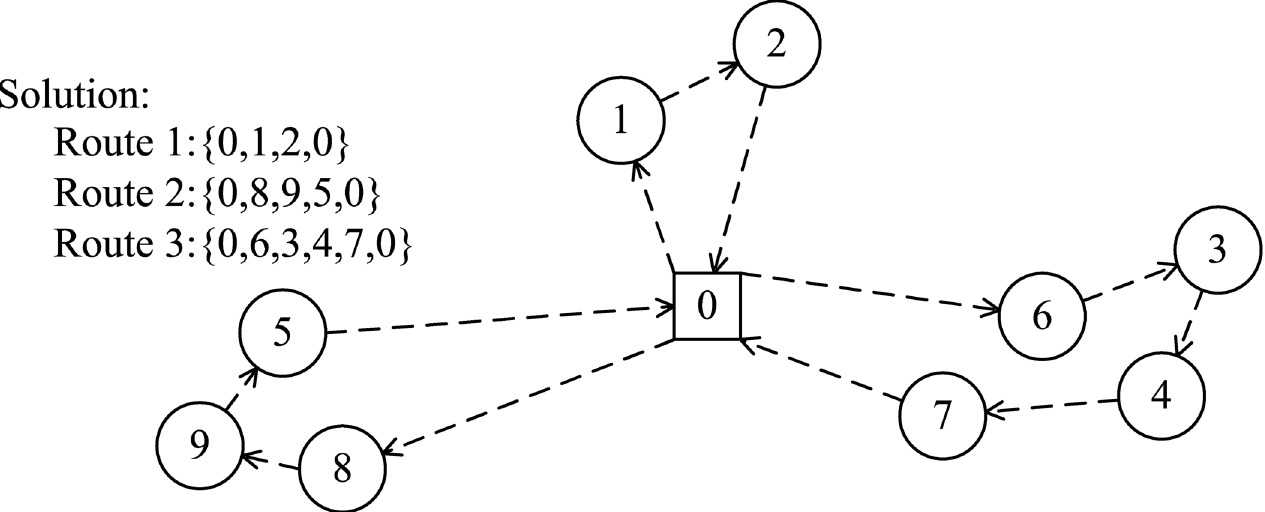
Fig 3. Example of a solution.